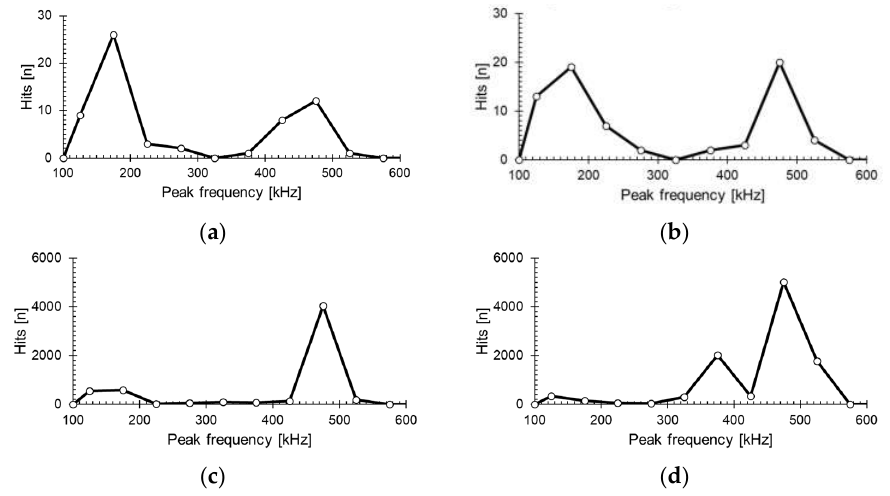
Figure 7. Frequency distribution of ( a ): [90] 16 , ( b ): [80] 16 , ( c ): [0] 8 , and ( d ): [0/90] 4 .